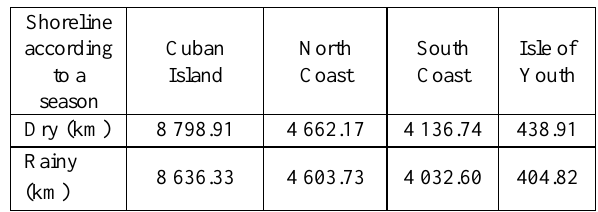
Table 4. Assessment according to results of the research work done for